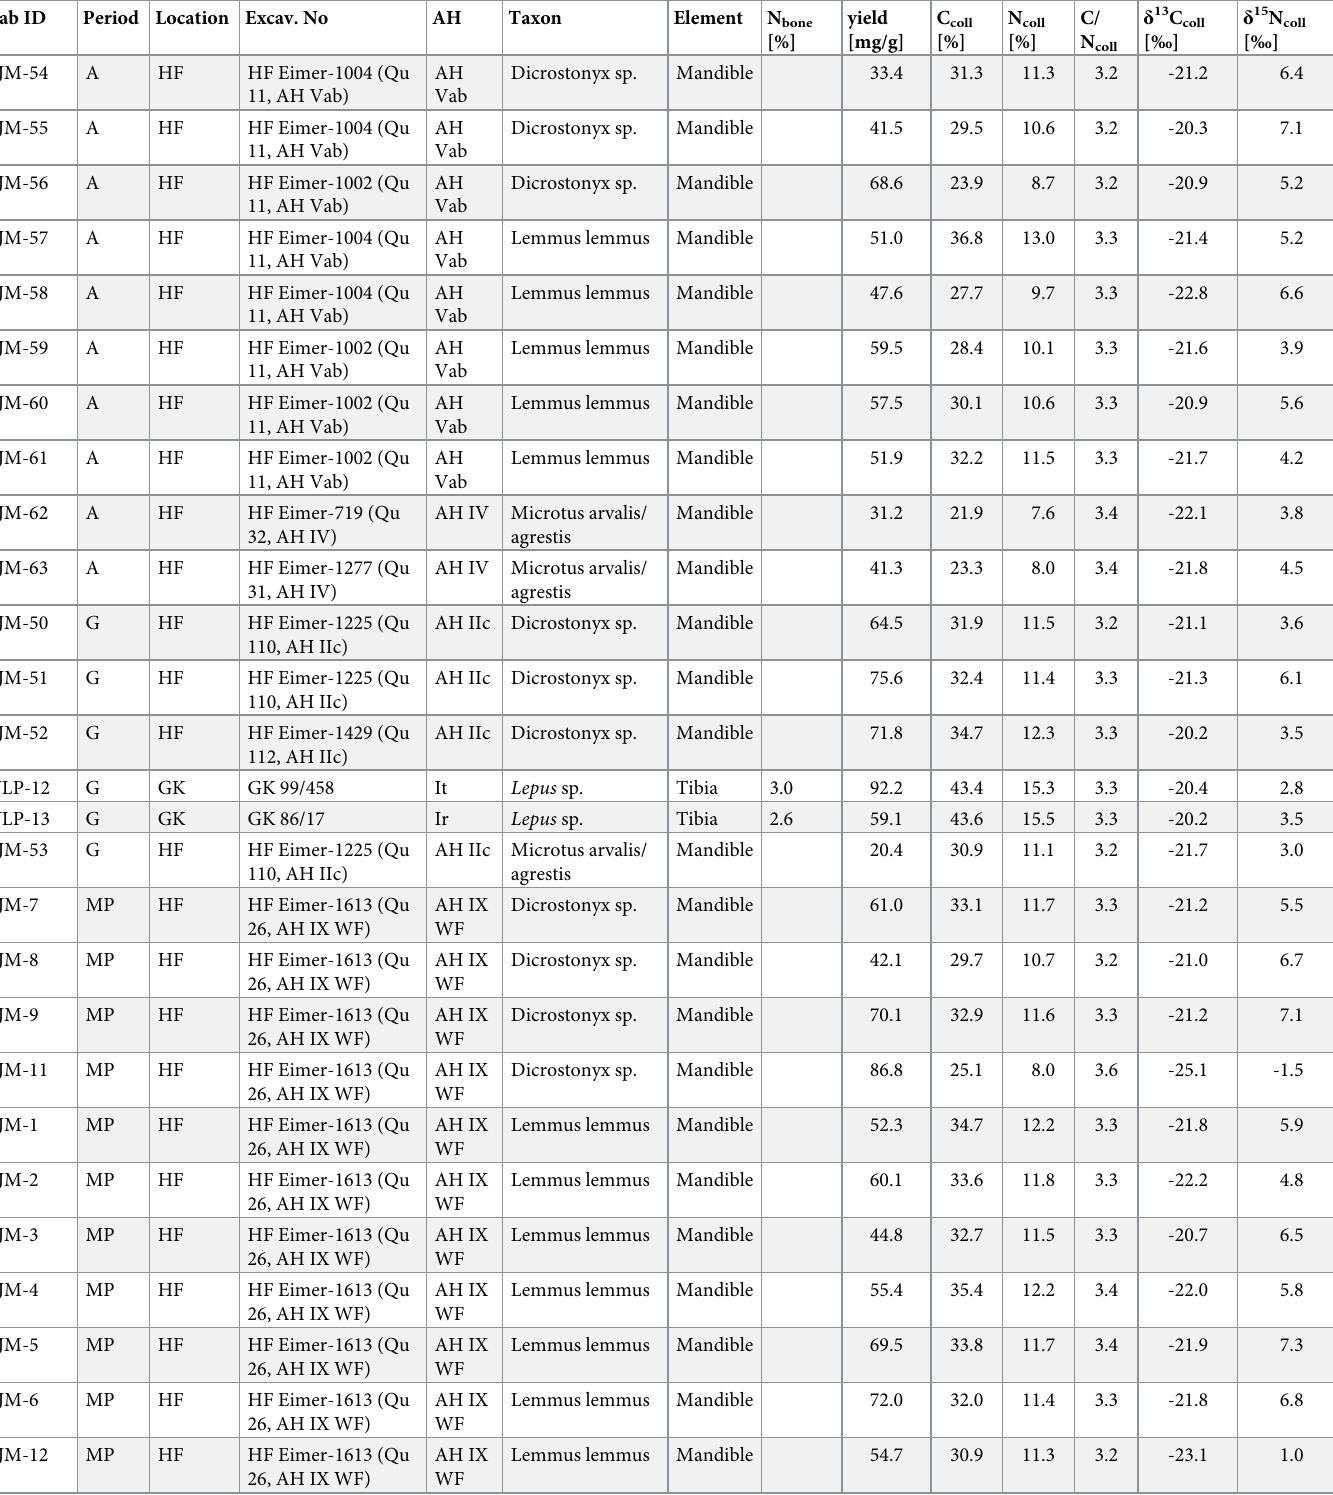
Table 2. List of newly analyzed isotopic values of rodents and hare reported in this study. Lab ID Period Location Excav.